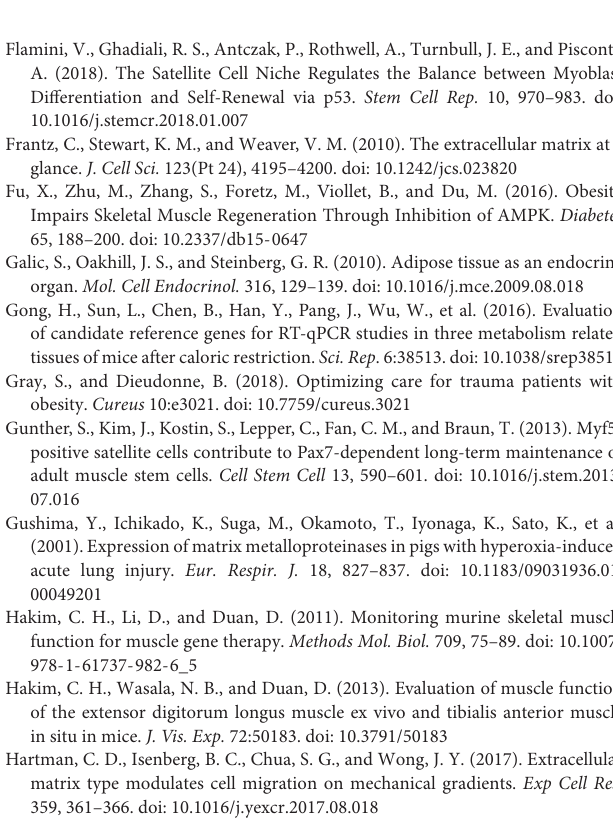
FIGURE S1 | Level of MMP2 and MMP9 activity follows the trend of gene profiling in lean and obese mice without showing significant differences between the diets. Gelatin zymography was performed to determine MMP2 and MMP9 activity in the muscle of lean and obese mice, in control mice as well as 1, 6, 24, 72, and 192 h post trauma ( n = 5). The data is normalized to the individual control by subtracting the baseline value of the control group from the determined band intensity of the individual time points. FIGURE S2 | Decreased number of Ki67 positive cells in regenerated muscle after trauma induction in obese mice based on IHC staining. Ki67 staining in muscle extensor iliotibialis anticus of male lean and obese C57BL/6J mice after induction of blunt injury ( n = 4). Ki67 staining was performed in obese and lean control mice as well as 6, 72, and 192 h post trauma. Obese mice show fat deposition (arrow) in between muscle fibers. Exemplary Ki67 positive cells are indicated with a triangle. Pictures were taken with the UC30 color camera at X10 and X40 magnification (OLYMPUS IX81). Scale bar: 200 µ m (X10), 50 µ m